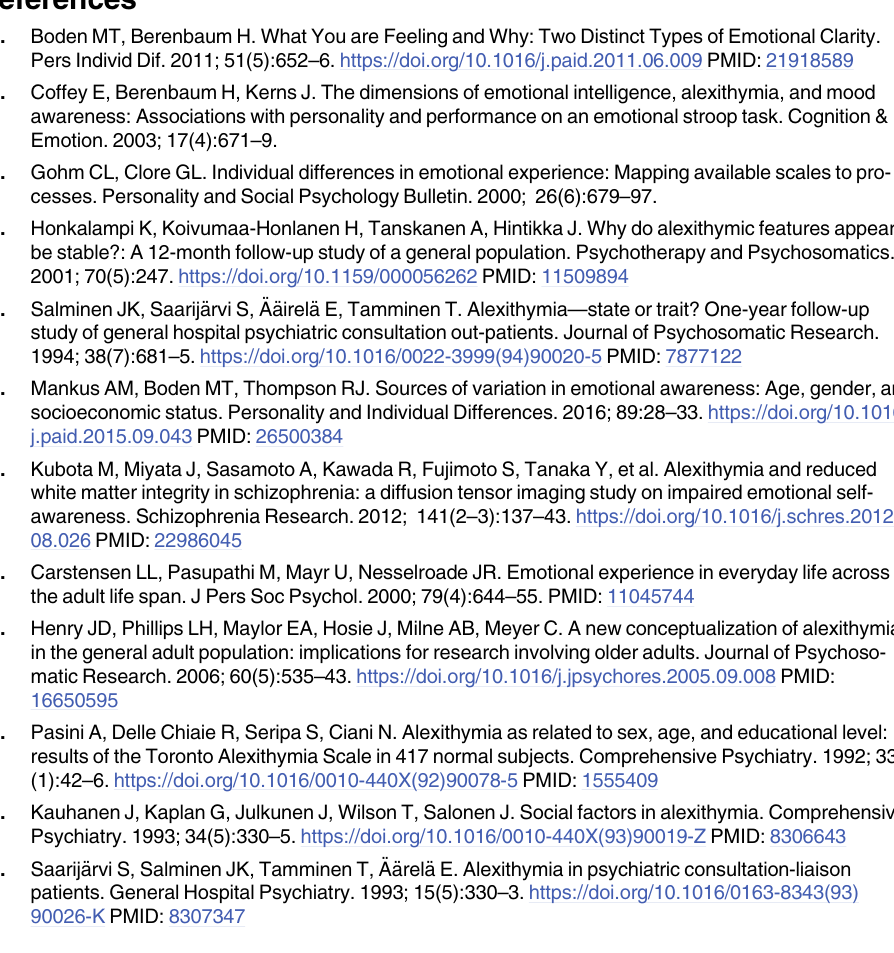
a False-Discovery-Rate, FDR, of 0.05). Note: the outline represents the mean corpus callosum outline across all participants and with anterior corpus callosum on the left side of each panel. Vertical dashed lines indicate the callosal subdivision as implemented in the area and FA anal-